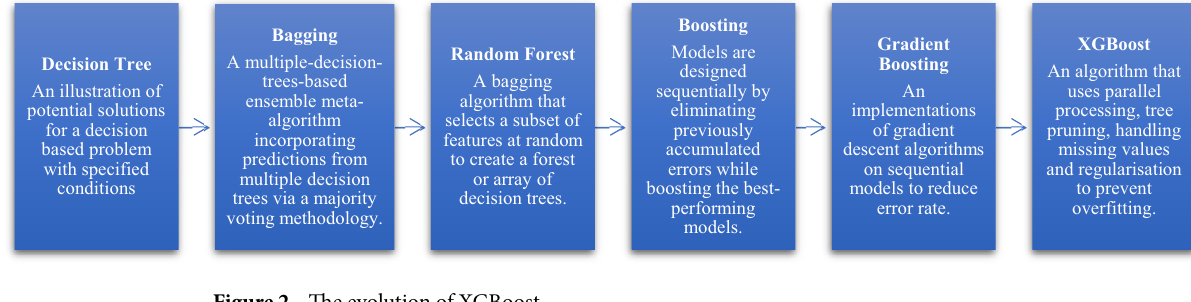
Figure 2. The evolution of